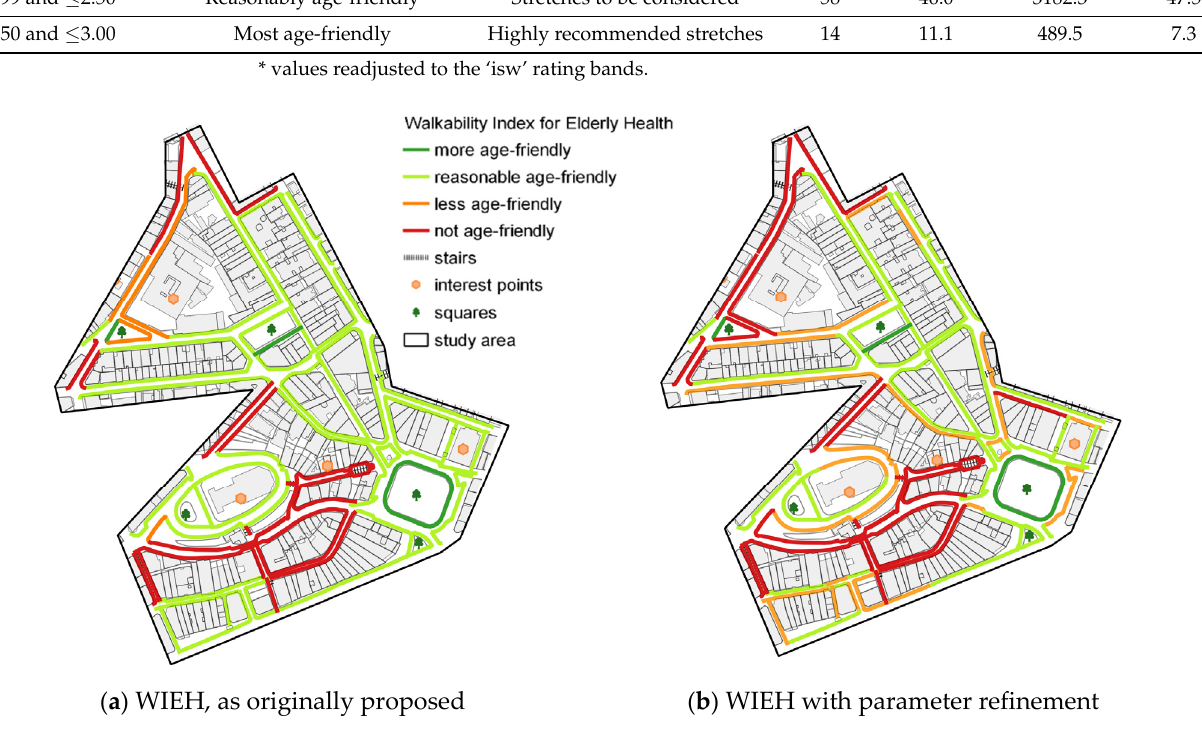
Figure 13. Comparison of WIEH ratings as per initial parameters in the previous study and the WIEH reclassifications in this study, through parameter refinement ( a ) WIEH as per Table 15 and Figure 9; ( b ) final WIEH, with the adjusted parameters, as per Table 17 (values of the ‘isw’ rating bands).